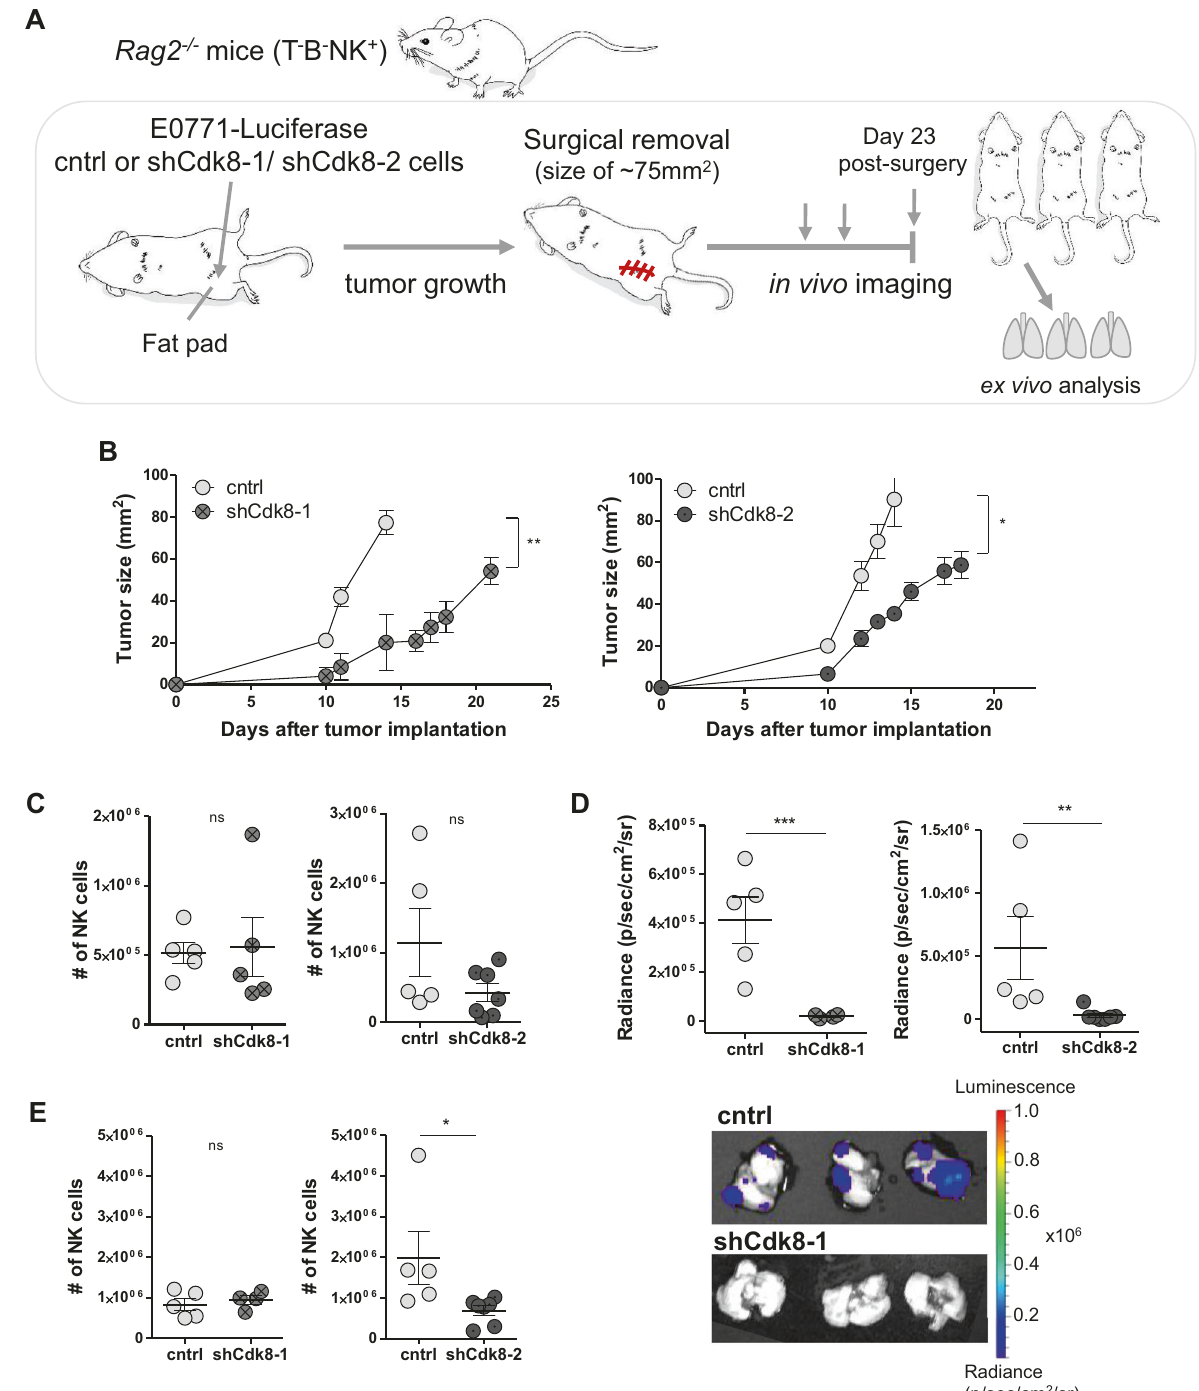
Fig. 4 Loss of CDK8 in TNBC enhances NK-cell-mediated tumor surveillance. A Experimental setup of data shown in ( B – E ). Rag2 − / − mice were orthotopically transplanted with E0771 control, shCdk8-1, or shCdk8-2 cells (in independent experiments) and monitored for primary tumor growth. Tumors were surgically removed and regrowth and distant metastasis formation of tumor cells was monitored with in vivo imaging. B In vivo primary tumor growth for control vs. shCdk8-1 or shCdk8-2 E0771 cells in the left and right panel, respectively. C Total in fi ltrating NK-cell numbers (CD45 + NK1.1 + NKp46 + ) of digested primary tumors at day of surgery. D Radiance signals of lungs ex vivo measured by an in vivo-imaging system and representative pictures of lungs (lower panel) at the end of the experiment (day 23 post surgery). E Total numbers of in fi ltrating NK cells (CD45 + NK1.1 + NKp46 + ) of lung lysates were assessed. Symbols and error bars represent mean ± SEM ( n = 4 – 9 mice per